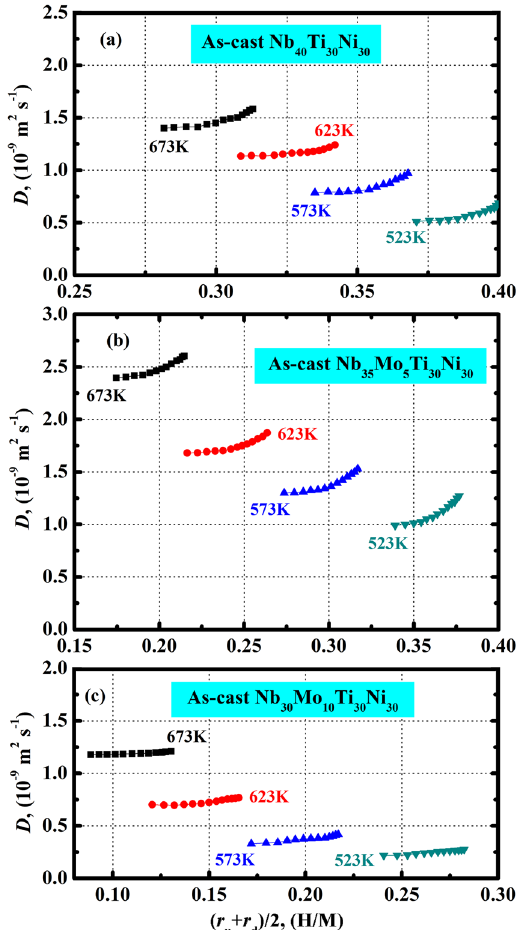
Figure 7. Concentration dependent apparent hydrogen diffusion coefficient ( D ) for the as-cast Nb 40 Ti 30 Ni 30 ( a ), Nb 35 Mo 5 Ti 30 Ni 30 ( b ) and Nb 30 Mo 10 Ti 30 Ni 30 ( c ) alloy membranes at 523 … 673 K. The hydrogen concentration is given by ( r u + r d )/2 which corresponds to an average H/M values at the upstream and downstream surfaces of each